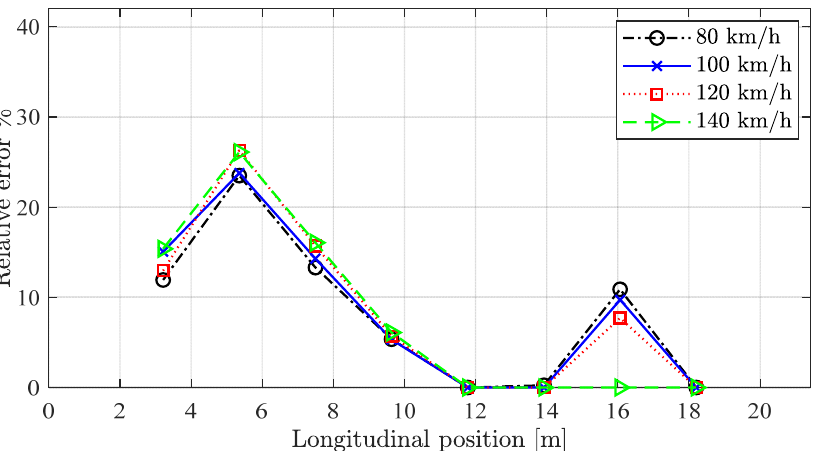
Figure 16. Relative identification error as a function of travelling speed and damage position, with the CSA train and a slight change of irregularity profile.